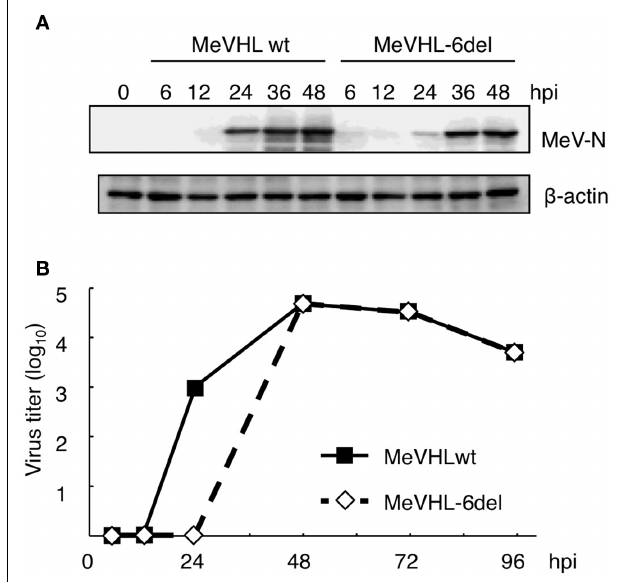
FIGURE 5 | La interaction with N-5 (cid:2) UTR affects the replication of MeV at an early phase of infection. (A) The expression levels of N protein in B95a cells infected with wild-type MeV or MeVHL-6del were determined by western blotting. As an internal control, β -actin protein was measured. (B) The growth kinetics of MeVHL-6del.Wild-type MeV (straight line) and MeVHL-6del (dotted line) were inoculated to B95a cells at an moi of 0.001, and harvested at the indicated time point.The average of two independent measurements is